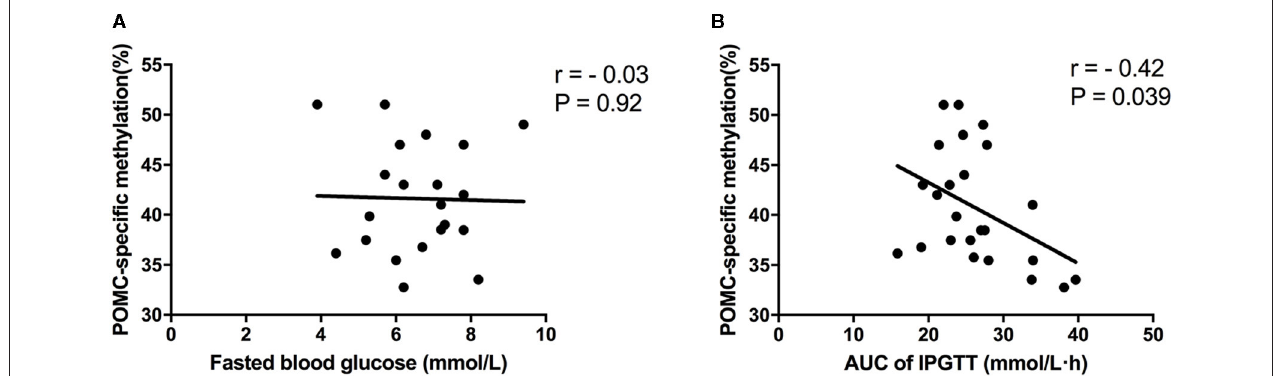
FIGURE 6 | Correlation analyses between POMC methylation and glucose metabolism status. (A) POMC-specific methylation (%) and fasted blood glucose; (B) POMC-specific methylation (%) and AUC of ipGTT. Data were represented as mean ± SEM ( n = 6–8/group). Diet abbreviations: NC, normal chow; LP, low protein; HF, high fat. Dam and pup diets denoted before and after the dash line,